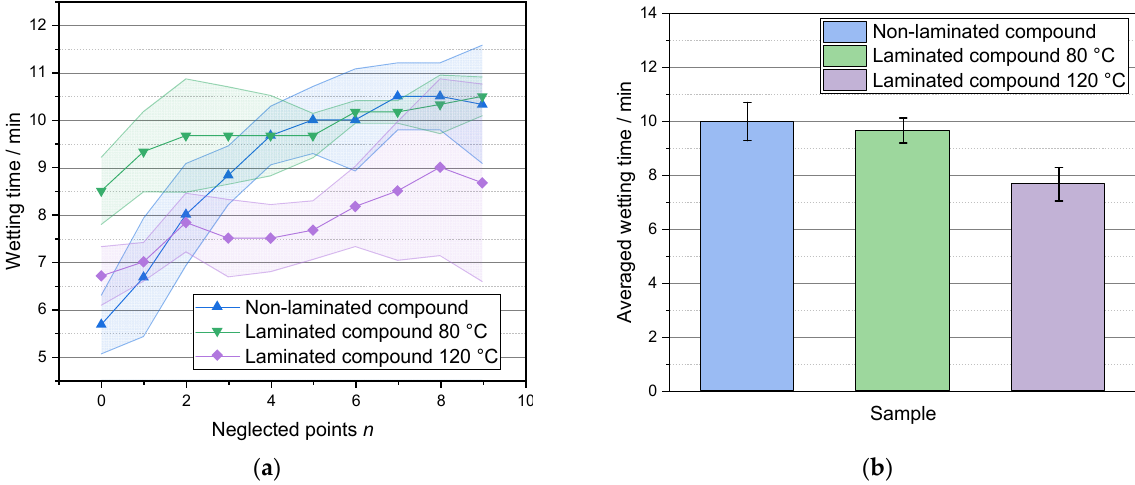
Figure 8. Averaged wetting time for the samples studied by means of impedance measurements in dependence on the neglected points 𝑛 at the beginning of the measurement and the respective standard deviations ( a ). Averaged wetting times for the three samples when neglecting 𝑛 = 5 points of raw data ( b ).